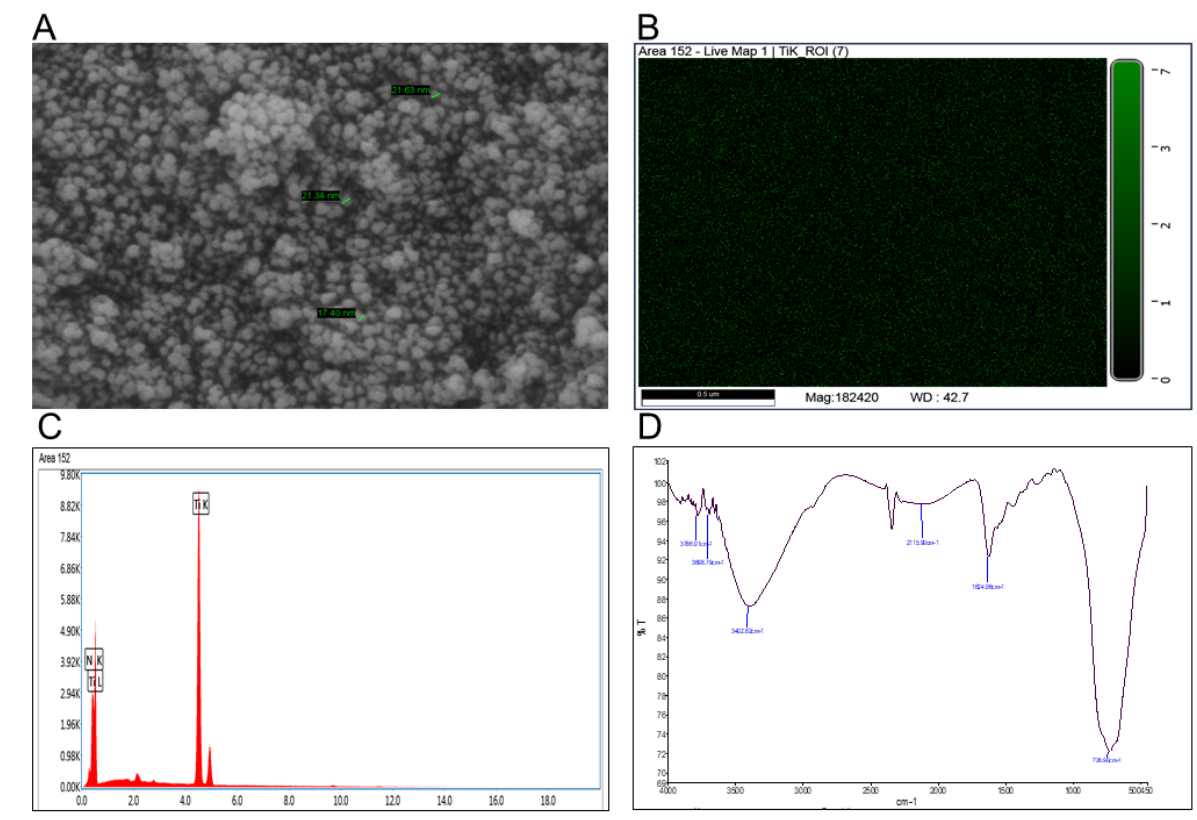
Figure 12. SEM image showing size dstribution of TiO 2 -NPs ( A ), EDAX map TiO 2 -NPs to confirmtion the presence of Ti ( B ), quantification of Ti by EDAX in the TiO 2 -NP ( C ) and FTIR showing distribution of different bonds present in TiO 2 -NPs ( D ).